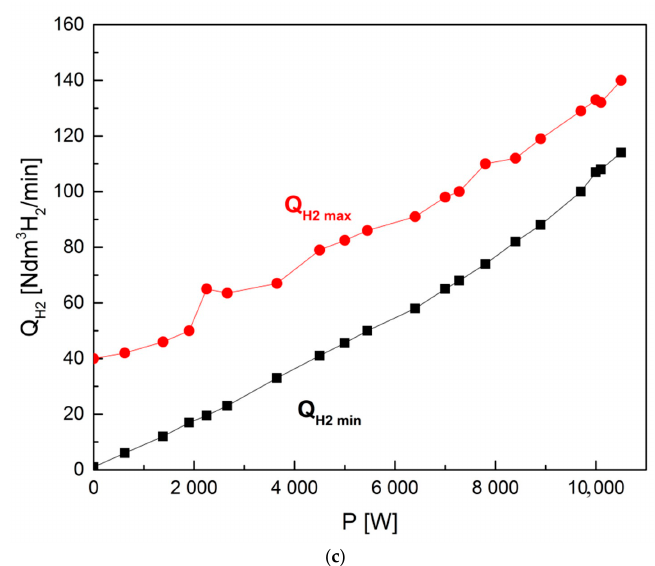
Figure 11. ( a ) Variation in intensity of hydrogen flow Q H2 vs. time recorded during V-type PEMFC stack operation. ( b ) Indication of the effect of a purge (Purge 1 or Purge 2) and humidification realised by means of SCU1 or SCU2 processes vs. time on hydrogen utilisation Q H2 during V-type PEMFC stack operation. The conditions are reflected in (a) (a narrower excerpt from the time graphs in (b)). ( c ) Hydrogen fuel consumption Q H2 : minimal Q min or highest Q max values of the intensity of the flow of fuel during PEMFC stack operation under electrical load.